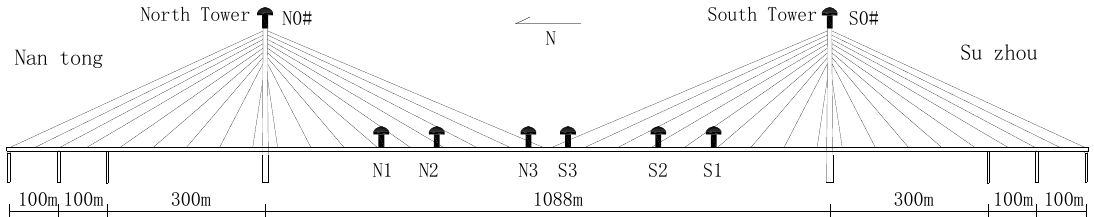
Figure 7. Layout of the GNSS monitoring points on Sutong Bridge.